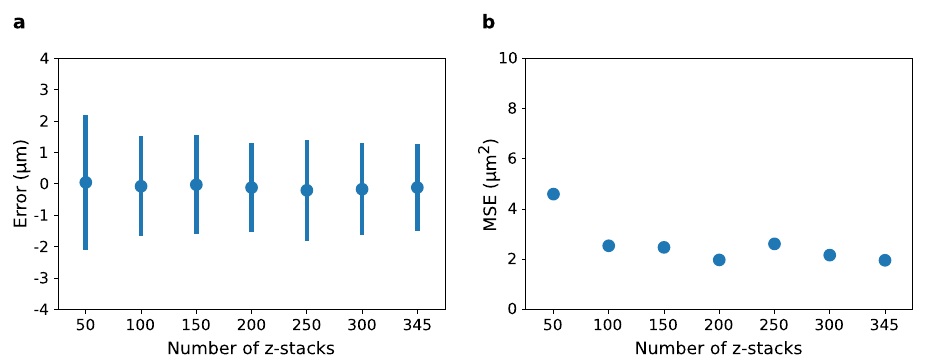
Figure 4. The relationship between accuracy and data set size. ( a ) Error as a function of the number of z-stacks in the data set. Symbols give the mean error and bars are ± 1 standard deviation. ( b ) The mean squared error (MSE) vs. data set